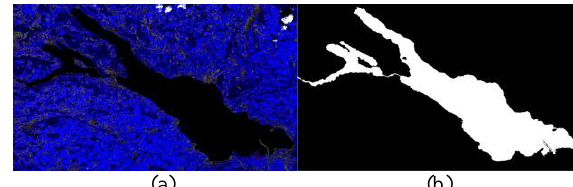
Figure 3. (a) Mean-Shift segmentation, (b) and thresholding